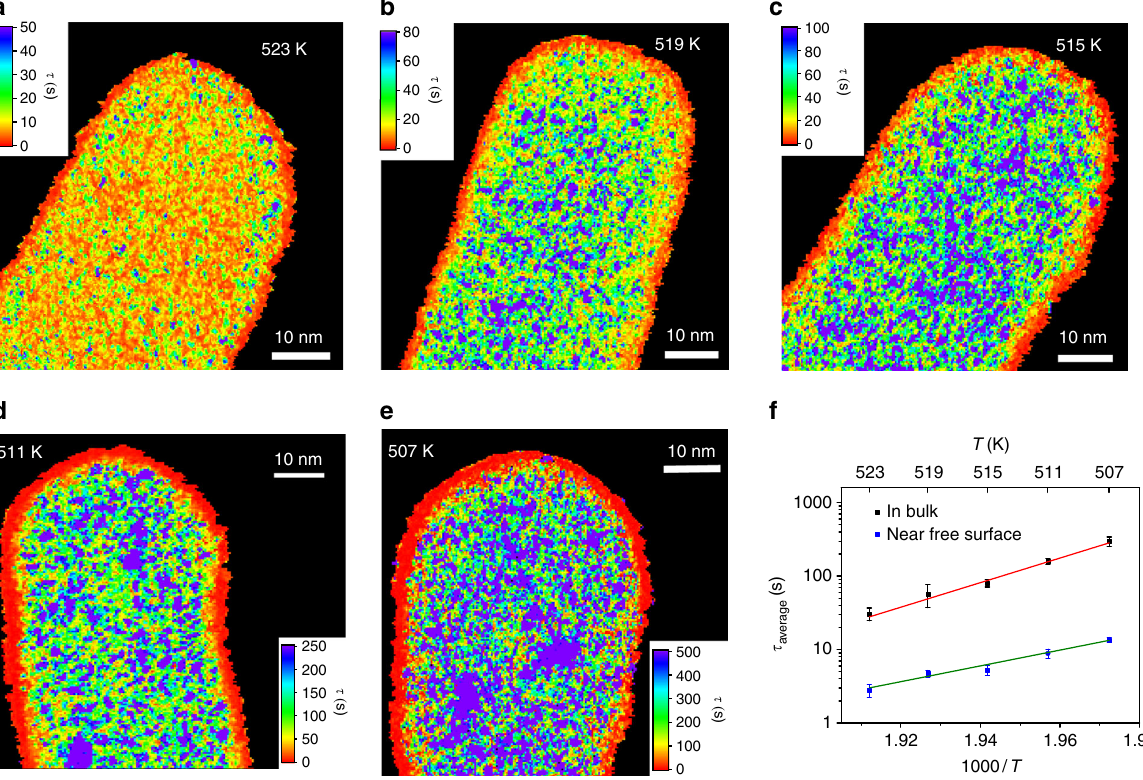
Fig. 2 Spatial maps of structural relaxation time on the nanowire in the supercooled liquid regime. a T = 523 K, b T = 519 K, c T = 515 K, d T = 511 K, e T = 507 K. The maps show domains with varying relaxation time at the nanometer scale. With decreasing temperature, slow domains appear larger and occupy a greater fraction of the map, especially very close to T g = 507 K. There is a region ~1 nm thick with ~20 times shorter relaxation time near the surface of every wire. f The mean structural relaxation time for the nanowire interior (bulk) and the near-surface layer. The error bars are the standard deviation of the mean of four measurements on different nanowires. Fitting to the Arrhenius form yields activation energies of 3.7 ± 0.3 eV for the bulk and 1.7 ± 0.3 eV for the